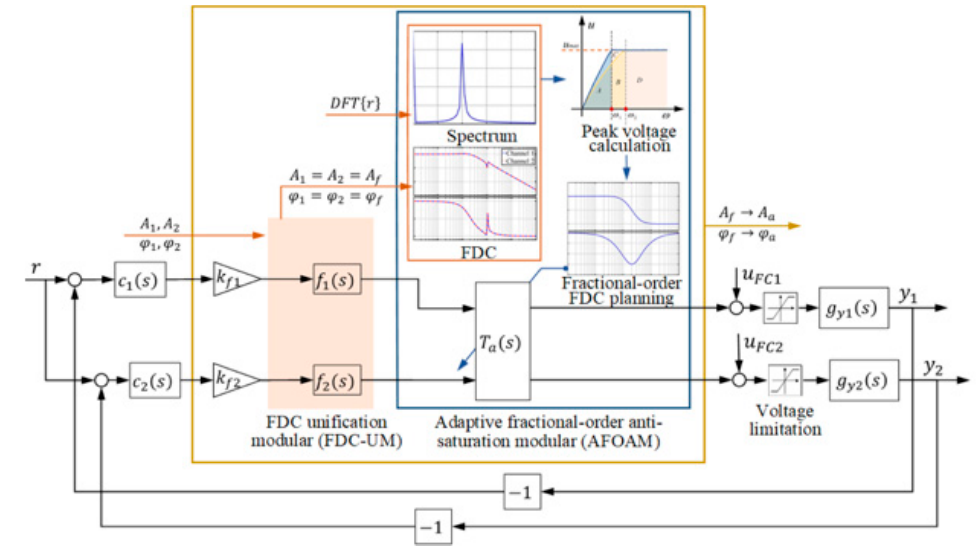
Figure 2. The transfer block diagram of the proposed adaptive fractional-order anti-saturation synchronous control method.